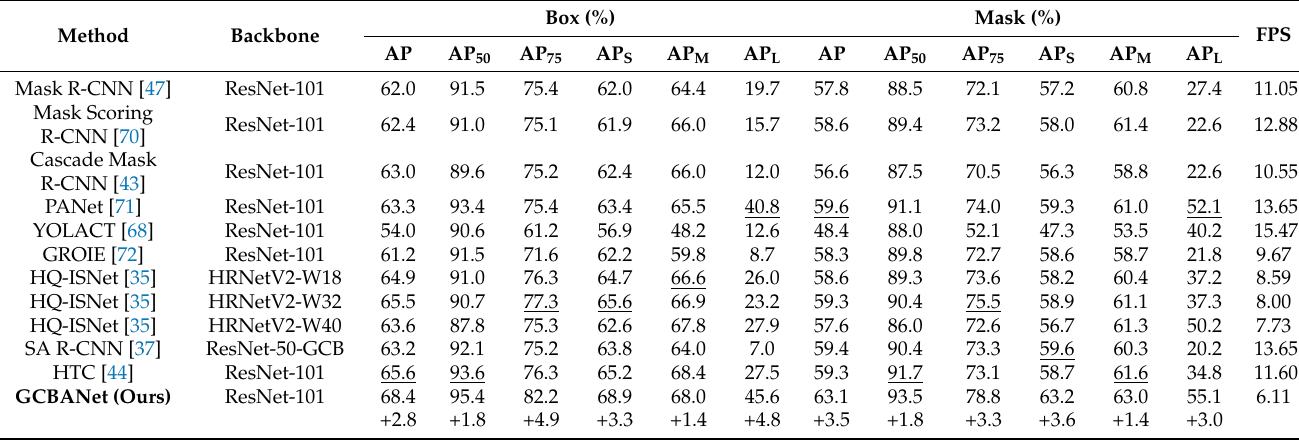
Table 2. Quantitative Results on SSDD. The suboptimal method is marked by underline